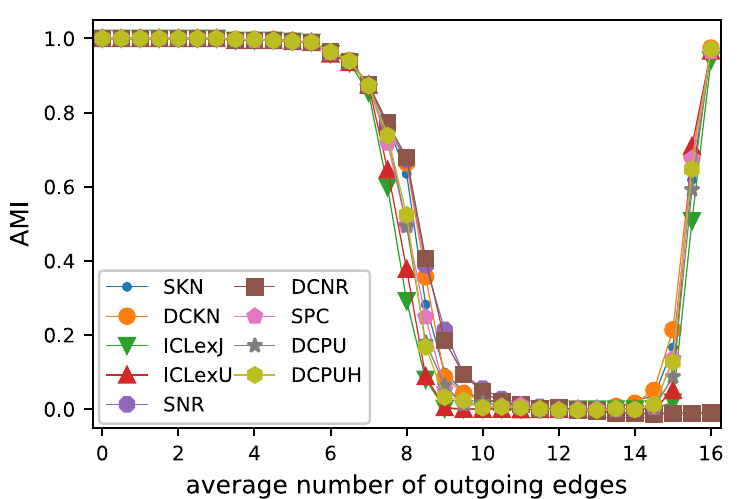
Fig 4. Results of Girvan-Newman test applied with a known number of groups. Each marker represents the average of 10 network instances. For each network each of inference algorithm (see Fig 5) were executed 10 times from random partitions with 4 blocks for each of the shown SBM variants. The AMI of the partition with the best objective value of all inference algorithms and all executions is taken into account. Since the results of the DCP algorithm are the same as the SKN for the case without model selection, the diagram only includes the results of SKN.